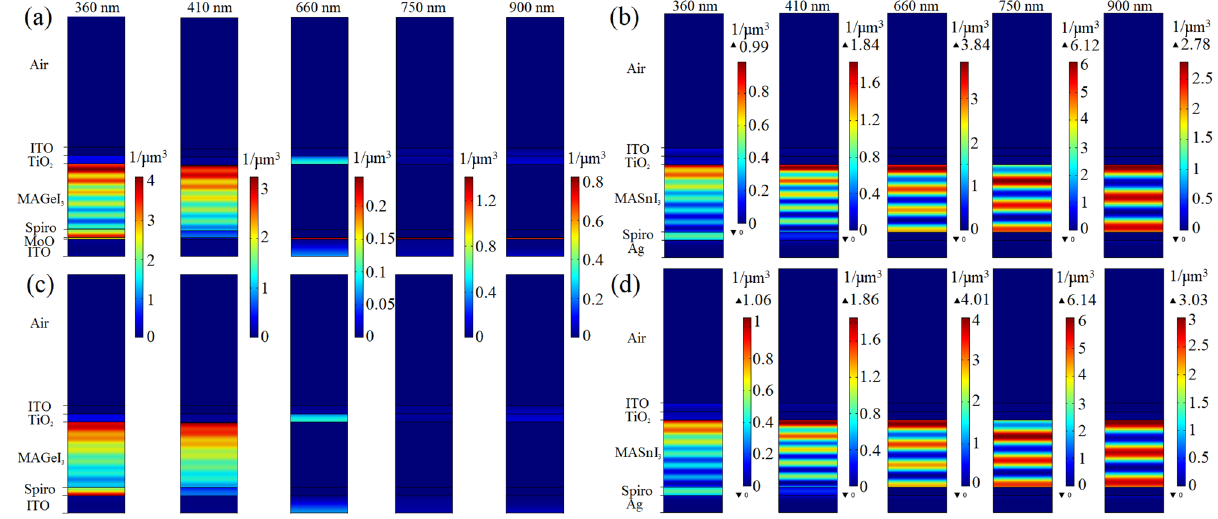
Figure 5. The absorption density distribution in the top sub cell of case (I) ( a ), in the bottom sub cell of case (I) ( b ), in the top sub cell of case (II) ( c ) and in the bottom sub cell of case (II) ( d ) for several